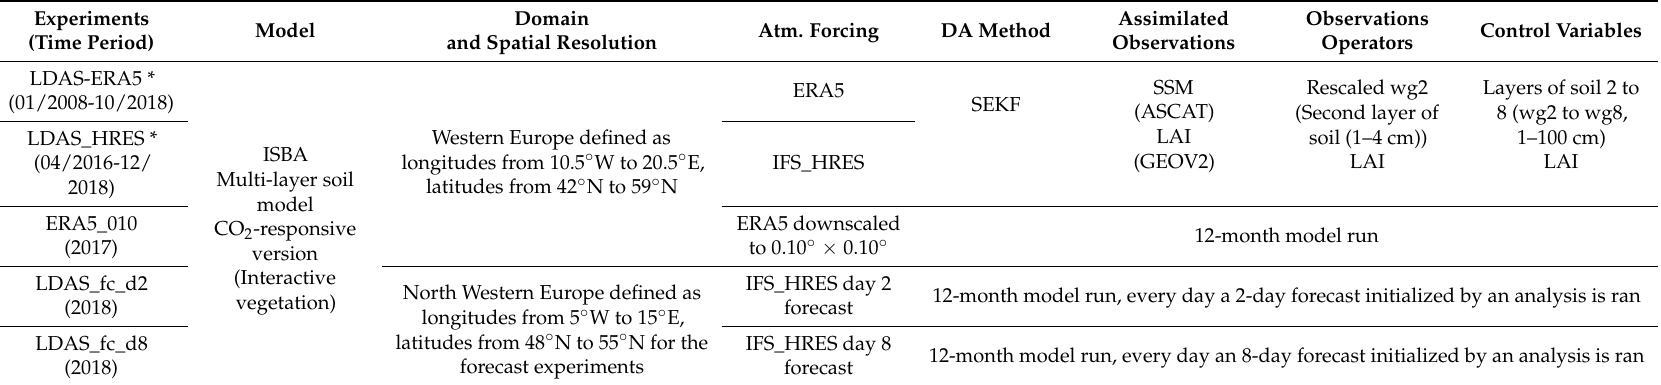
Table 1. Set up of the experiments used in this